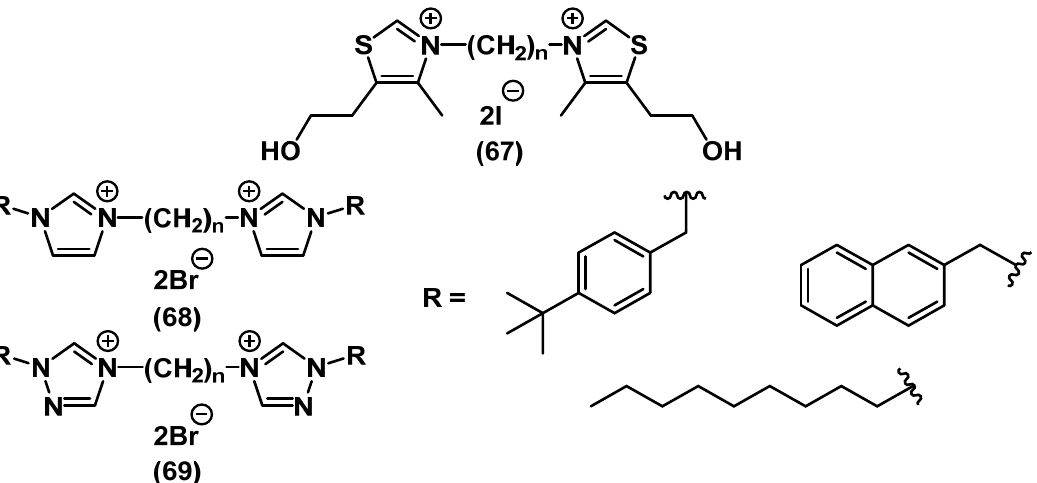
Figure 24. Bis-QACs containing saturated heterocycles. Thomas and colleagues synthesized QACs based on bis-thiazole 67 , bis-imidazole 68 and bis-triazole 69 . While thiazole derivatives with an alkyl spacer and without lipophilic MIC values lower than that of CHG